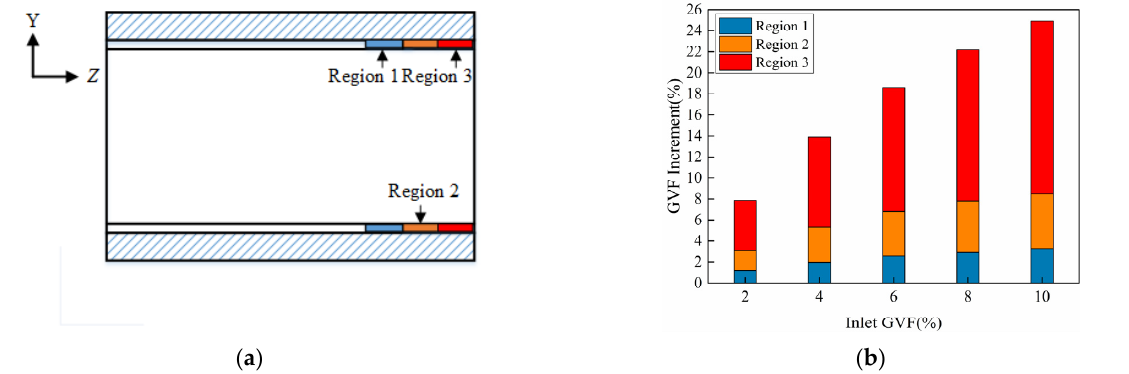
Figure 5. GVF distribution characteristics along the axial direction at specific regions. ( a ) Schematic diagram of the three specific regions, ( b ) GVF increment versus inlet GVF in regions 1, 2, and 3.